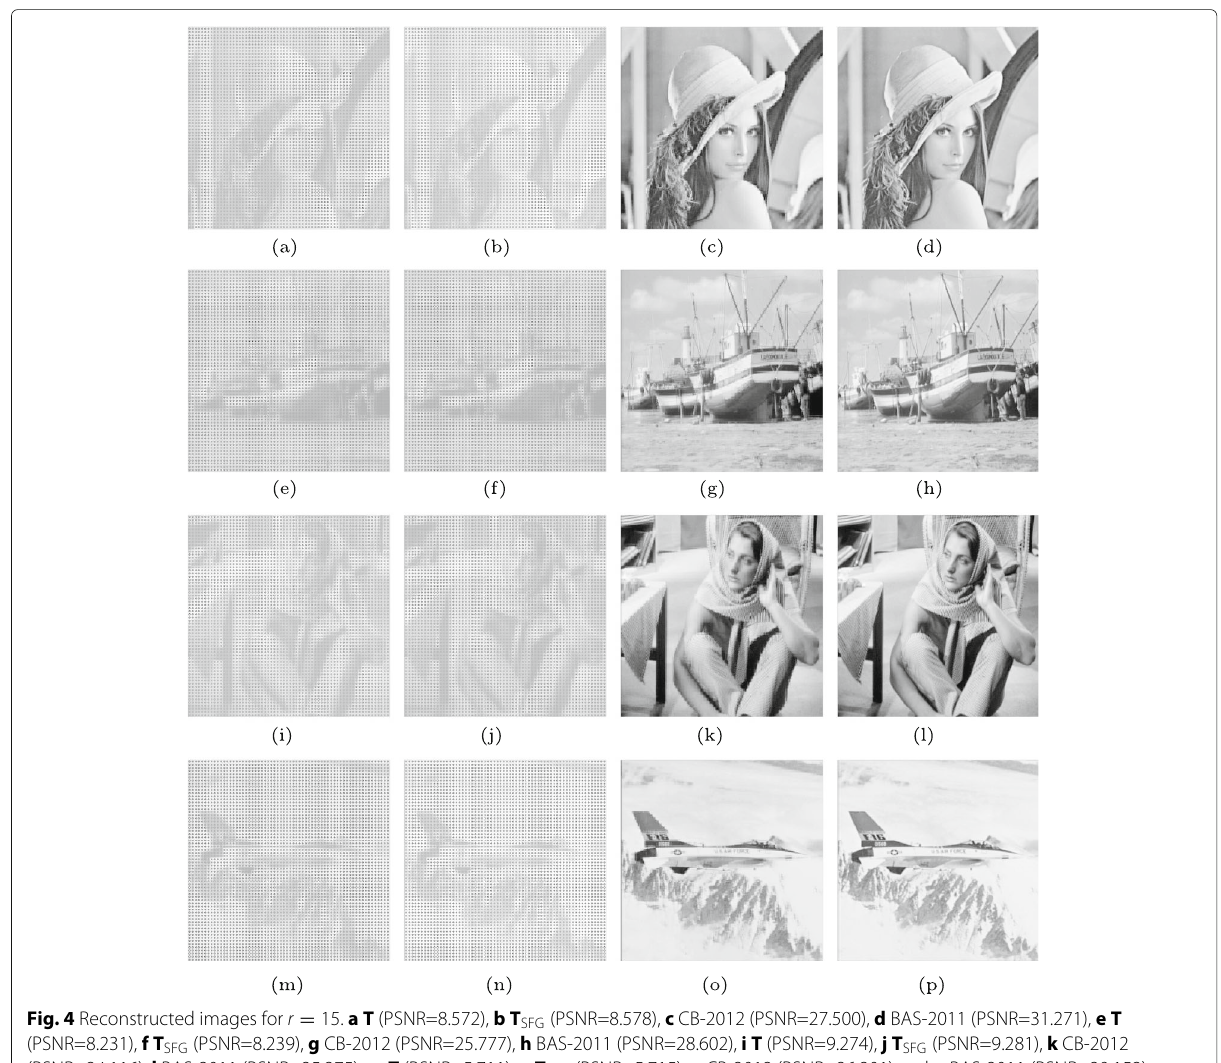
Fig. 4 Reconstructed images for r = 15. a T (PSNR=8.572), b T SFG (PSNR=8.578), c CB-2012 (PSNR=27.500), d BAS-2011 (PSNR=31.271), e T (PSNR=8.231), f